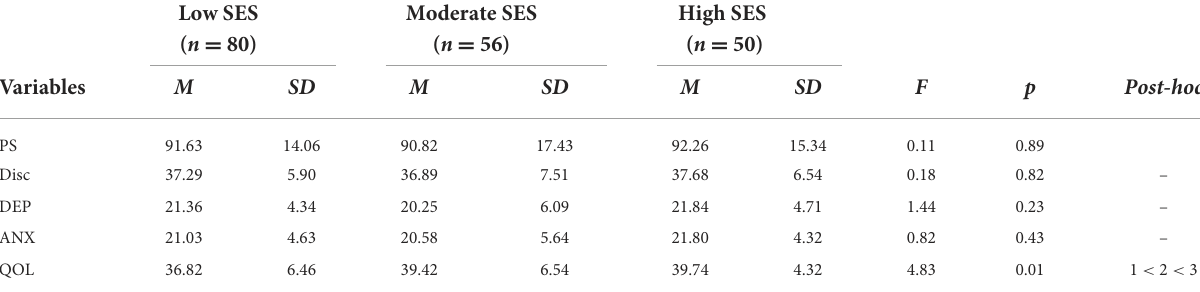
TABLE 4 ANOVA analysis showing mean, standard deviation and F value for socioeconomic status among epilepsy patients on variables of the